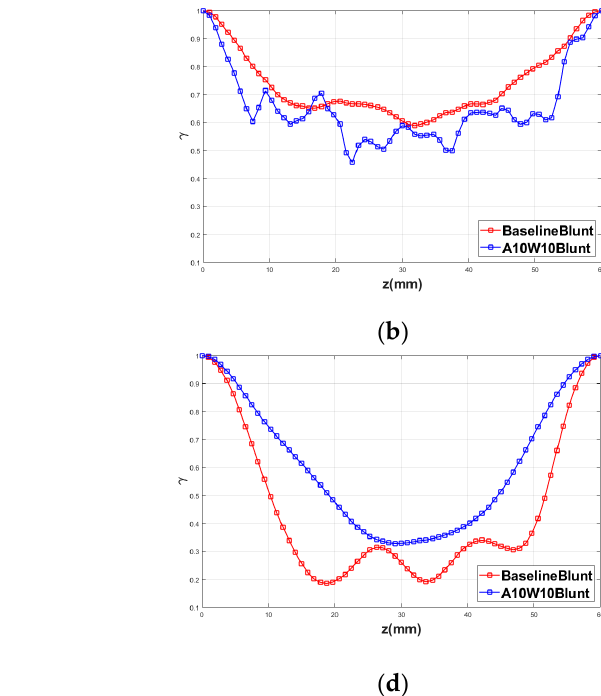
( b ) ( c ) Figure 19. Spanwise correlation analysis of the pressure fl uctuations at various streamwise loca- tions: ( a ) x = 0.0 c ; ( b ) x = 0.95 c ; ( c ) x = 0.98 c . Figure 20 shows the distributions of the spanwise coherence coe ffi cient of the surface- pressure fl uctuations at di ff erent frequencies. There were 65 spanwise monitor points at 0.98 c on the airfoil’s surface. The spanwise coherence coe ffi cient for di ff erent spanwise locations at each frequency was computed by Equation (11). It was found that the